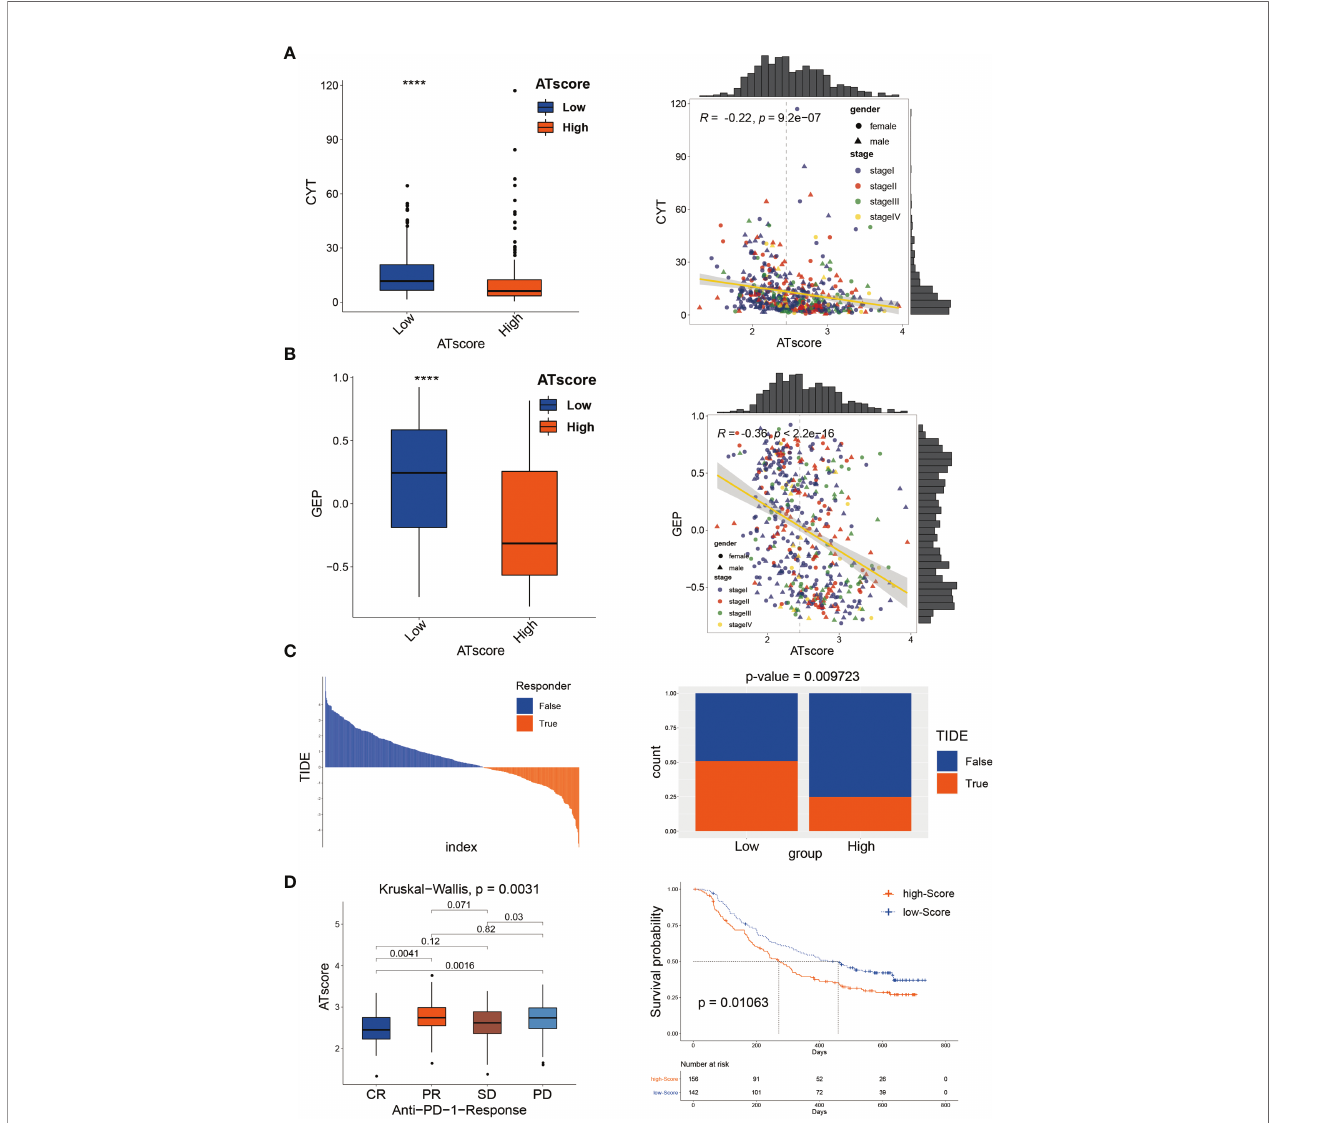
FIGURE 8 | The autophagy signature predicted immunological therapeutic bene fi ts. The patients with lower ATscore in the TCGA cohort had relatively higher CYT (A) and GEP (B) scores compared with those had higher ATscore. The results of TIDE algorithm showed that patients with higher ATscore in TCGA cohort might get poorer immunotherapy response than patients with lower ATscore (C) . In IMvigor210 cohort, patients with higher ATscores also had poorer anti-PD-1 response and prognosis than those with lower scores (D) .